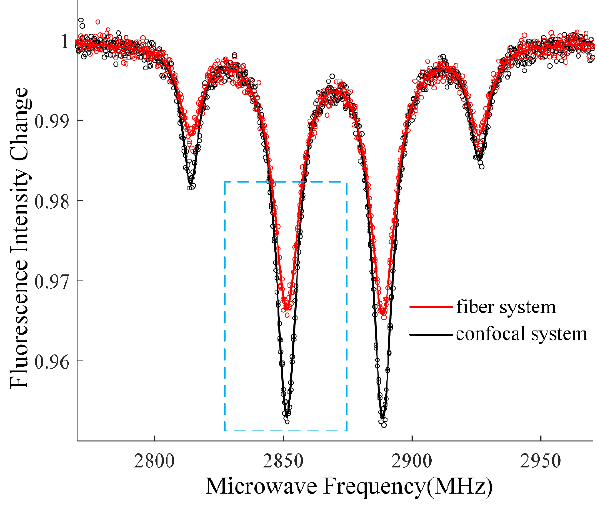
Figure 5. ODMR spectrum with 20 Gauss magnetic field. Although, the all-fiber NV center magnetometer had higher fluorescence intensity. The all-fiber NV center magnetometer had a slightly lower sensitivity because of the wider linewidth and smaller contrast, compared with the confocal system. In the confocal system, laser was focused by the objective, resulting higher laser intensity distribution near the focal point where was the laser excited and fluorescence collected area of the diamond. The optical pumping rate of NV centers is proportional to the laser intensity. The ODMR spectra linewidth narrowing and contrast enhancement effect with increasing pumping rate has been discussed by Jensen et al. [30]. Compared with the fiber system, the linewidth of the confocal system deceased from 10.2 MHz to 8.8 MHz, and the contrast boosted from 3.2% to 4.6%, which agreed with Jensen, K. et al. ’s research result. Consequently,